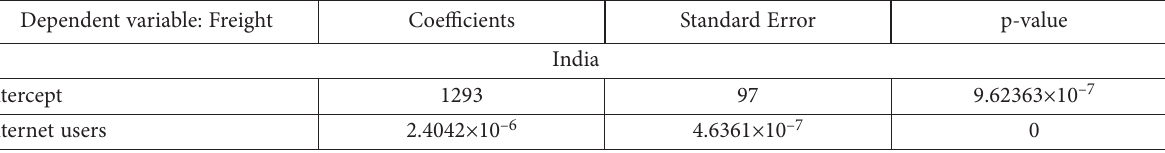
Figure 10. Regression result of registered carrier departures in India from 2008 to 2017 Table 6. Regression analysis of freight in four sample countries from 2008 to 2017